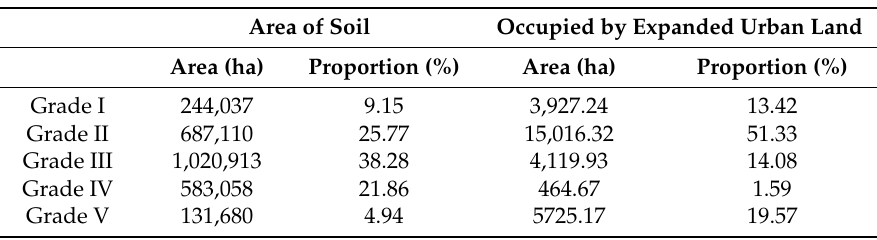
Table 8. Quality of soils urbanized in the CJEZ.